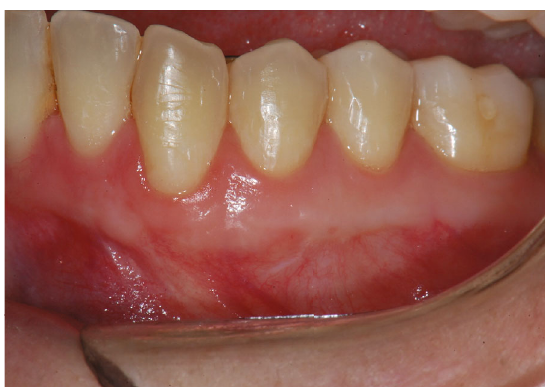
Figure 10: Close view of the treated area. Complete root coverage was obtained with 4mm of keratinized tissue. Note that the donor area also increased its dimension with no additional